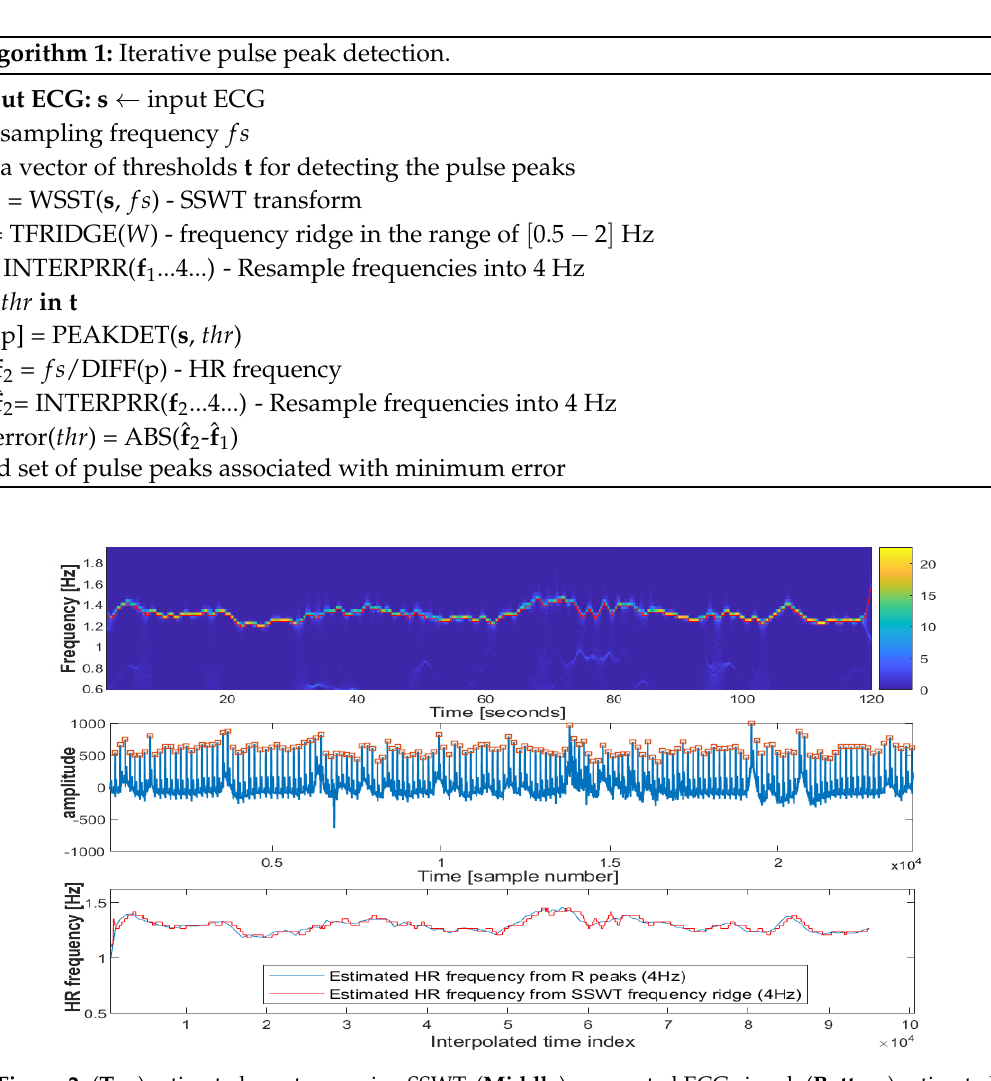
Figure 2. ( Top ) estimated spectrum using SSWT. ( Middle ) segmented ECG signal. ( Bottom ) estimated HR frequency from R peaks and SSWT (resampled into 4 Hz)